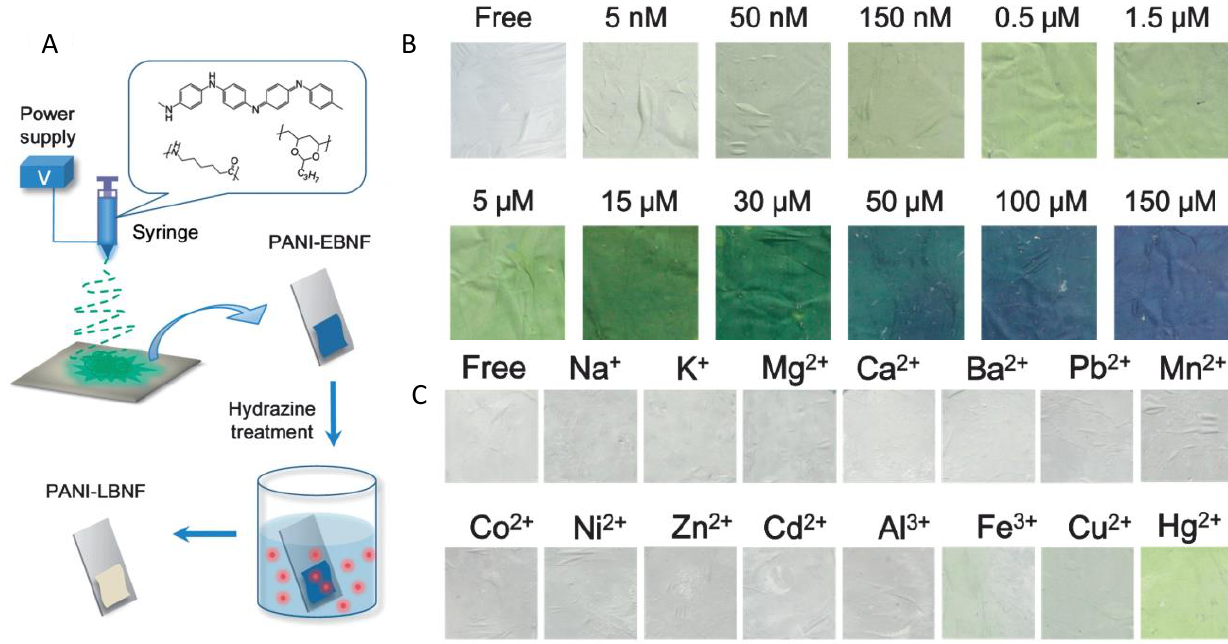
Figure 21. PANI-containing electrospun composite used for colorimetric sensing of Hg(II): ( A ) process for synthesis of PANI sensor strip showing electrospinning of a mixture of PANI, polyvinylbutyral, and poly(amide-6) and then treatment with hydrazine; ( B ) result of incubating PANI sensor strip in Hg(II) aqueous solutions showing progressive discoloration and darkening after contact with increasing Hg(II) concentration; ( C ) sensor strip after incubation in solutions of different metals, showing selectivity of sensing to Hg(II). Republished with permission of The Royal Society of Chemistry from [227]; permission conveyed through Copyright Clearance Center, Inc.